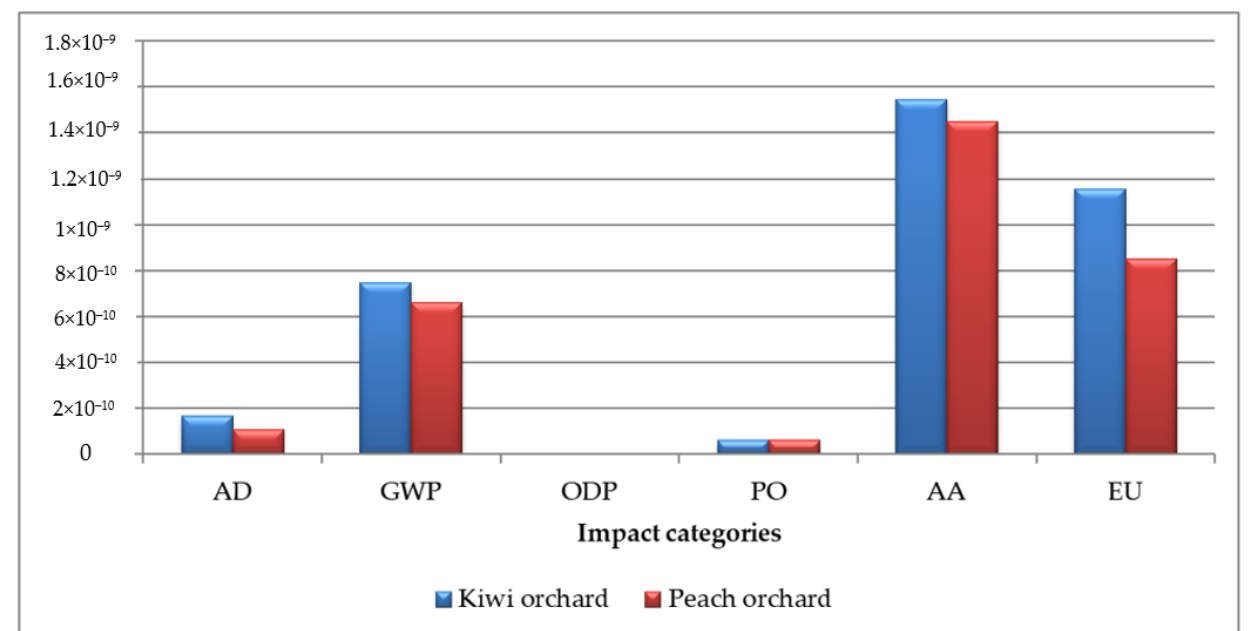
Figure 2. Normalization of the impact categories of the examined fruit orchard systems (AD: Abiotic